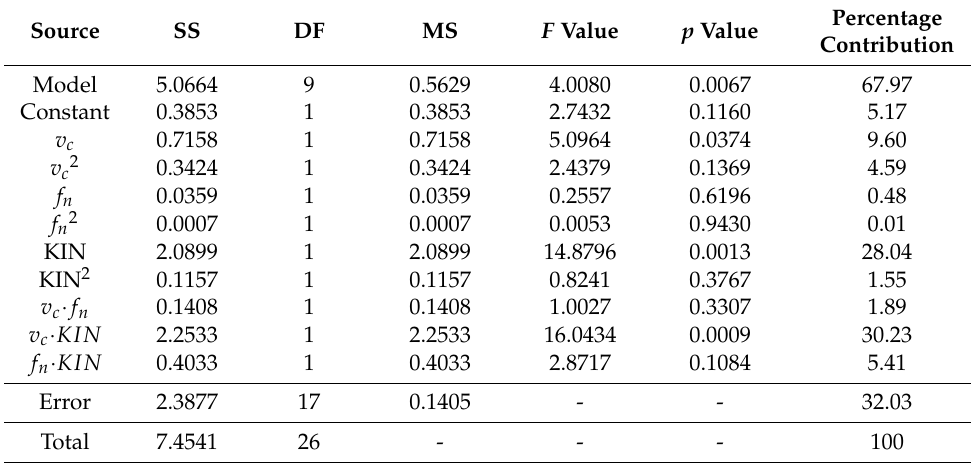
Table 8. ANOVA results for the roundness error.